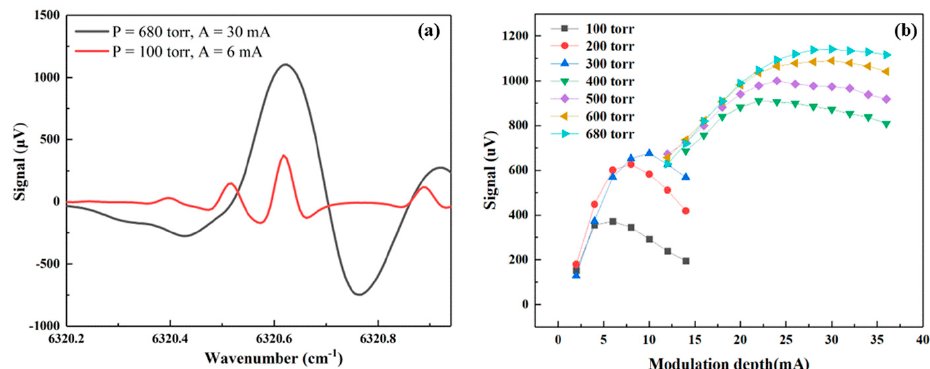
Figure 2. ( a ) The 2f WMS PAS signal of 100 ppm of H 2 S in N 2 from 6320.2 cm − 1 to 6320.95 cm − 1 at the pressure of 100 Torr and 680 Torr. ( b ) Peak signal at 6320.6 cm − 1 under different pressures and different current modulation depths. The experimental data are obtained at room temperature and with an integration time of 1s. The flow rate is 150 sccm.